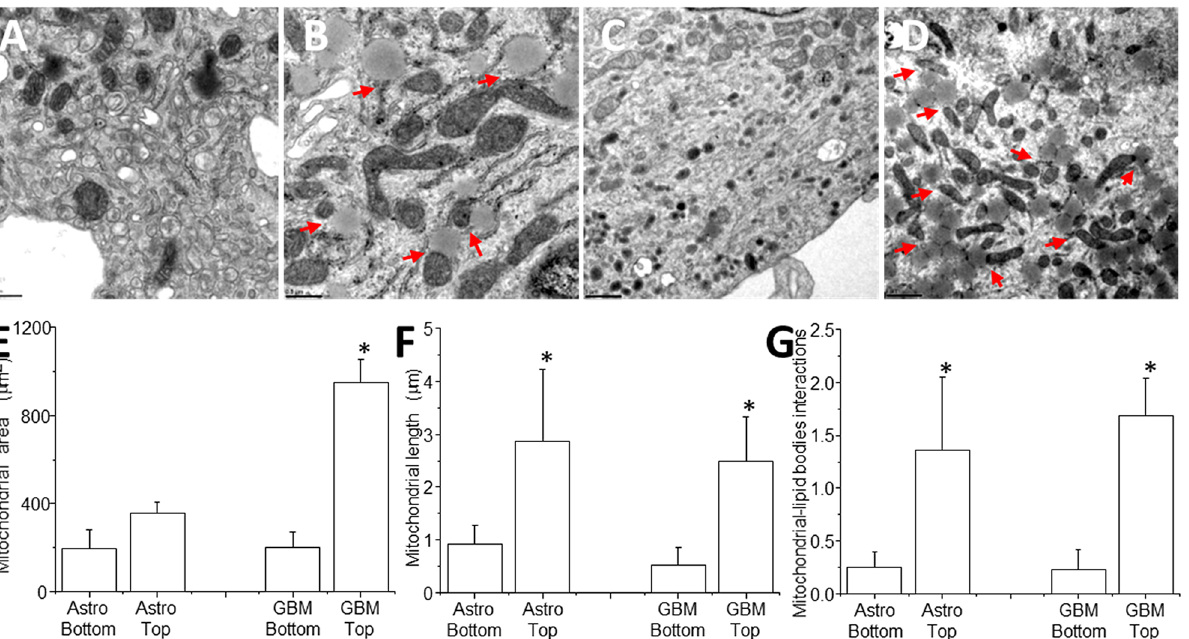
Figure 2. Mitochondrial heterogeneity in co-cultures of U87-GBM cells and human primary astrocytes. ( A – D ) Transmission electron microscopy (TEM) of co-cultures of GBM cells, U87-GBM, and human primary astrocytes indicates that tumor cells have a heterogeneous intracellular distribution of key organelles essential for TNT formation and transport. ( A , B ) Correspond to TEM from the same cells at the bottom and top optical sections of the cells, respectively. Arrows indicate the interactions between enlarged mitochondria and lipid bodies as well as the endoplasmic reticulum. Overall, top optical sections, where TNT are formed, present a bigger structure with more interactions with other organelles suggesting different metabolism. Arrows indicate these interactions. Bar: 0.5 µm. ( C , D ) Also, denote the same points of pictures ( A ) and ( B ), but at different magnification. Bar: 1 µm. ( E ) Quantification of the mitochondrial area at the top and bottom of cells in the co-culture system. GBM, top, has a higher mitochondrial area. ( F ) Quantification of mitochondrial length (µm) at the top and bottom sections. ( G ) Quantification of mitochondrial-lipid body interactions indicating the cells have intracellular heterogeneity and specific location associated with TNT formation (cells analyzed per experiment was 50 per condition, n = 5 independent